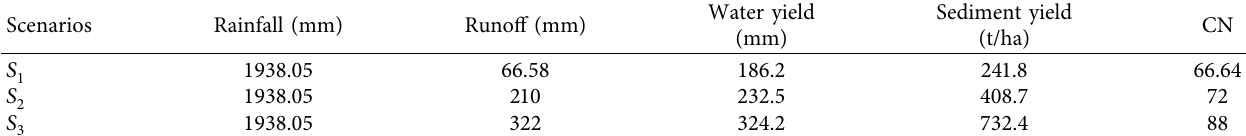
Table 10: SURQ, water yield, CN values, and sediment yield as a function of the model. Scenarios